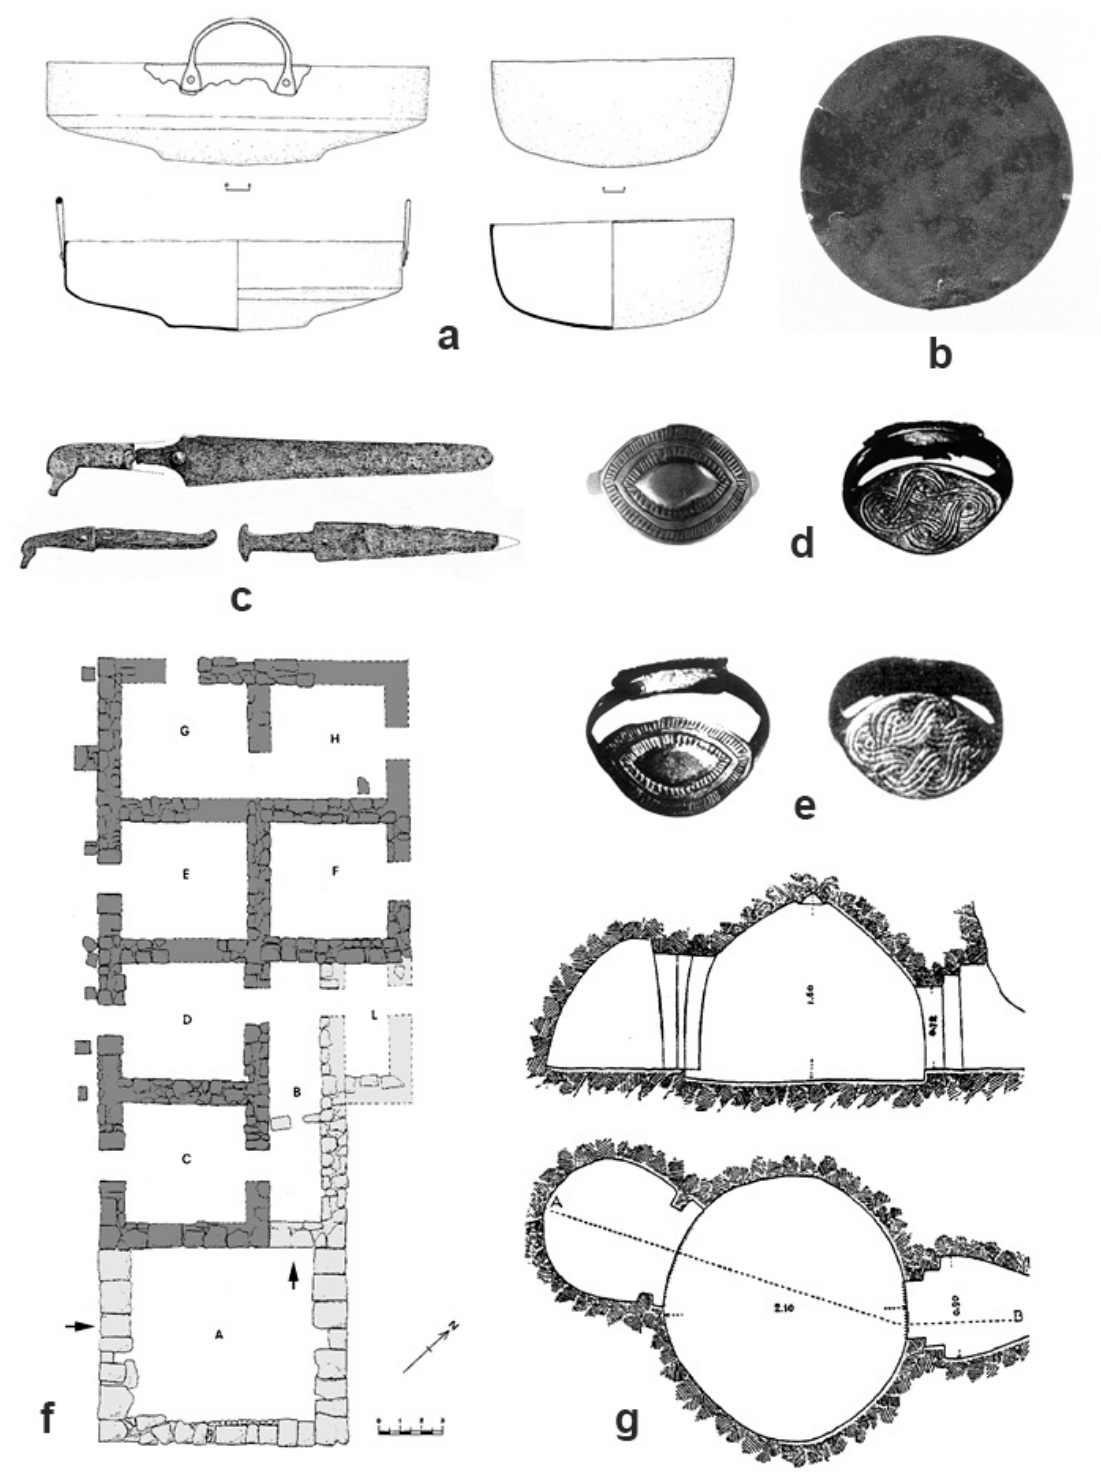
Figure 7: a) Metal basins from Capreria (Tanasi, 2010b); b) Bronze mirror from tomb 37 North of Pantalica (Tanasi, 2004a); c) Dagger with duck-head shaped metal and ivory hilt and miniature sword of Sandars type F from Pantalica (Tanasi, 2004a); d) Golden signet rings from Pantalica (Tanasi, 2004a); e) Golden signet rings from Montagna di Caltagirone (Tanasi, 2008); f) Multi-phased plan of the Anaktoron of Pantalica (Tanasi, 2004a); g) Tholoid chamber tomb 8 from Castelluccio Group at Montagna di Caltagirone (Tanasi,